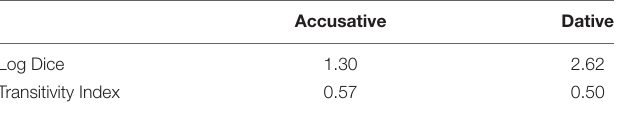
TABLE 5 | Overall Log Dice and transitivity index means across all countries and